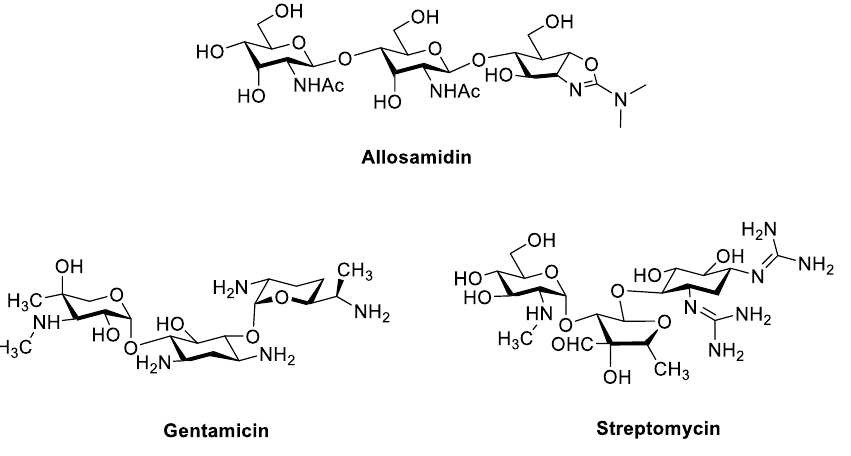
Figure 1. Some examples of relevant rare sugar-based bioactive molecules. Taking into consideration the relevant biological roles of GlcNAc and GalNAc as con- stituents of N -linked and O -linked oligosaccharides, AllNAc can be considered a promising